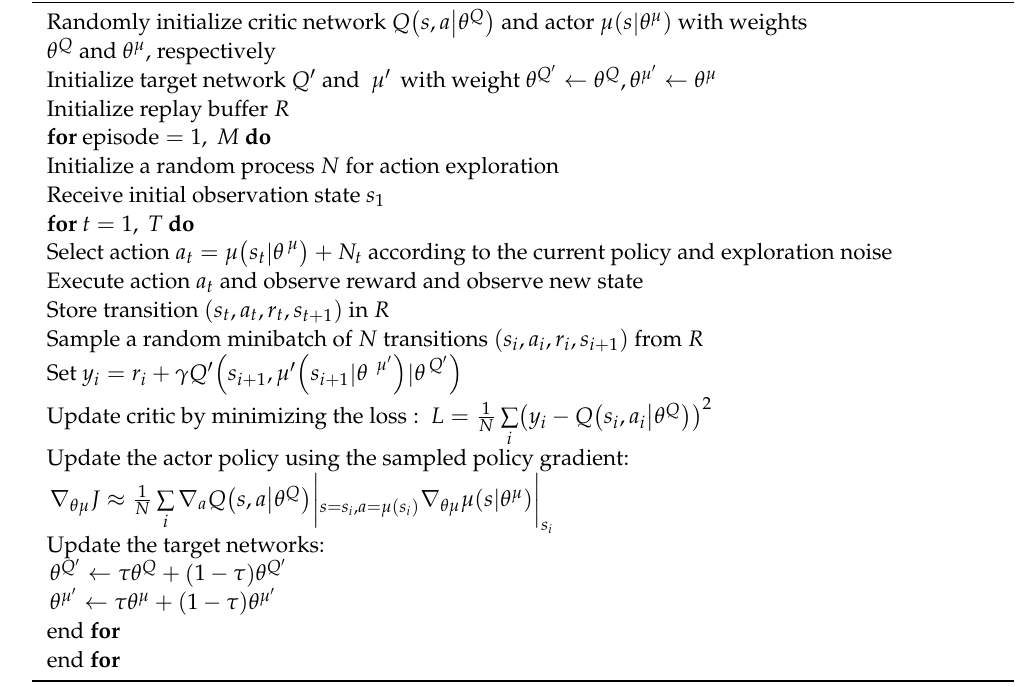
Algorithm 2 Deep Deterministic Policy Gradient algorithm